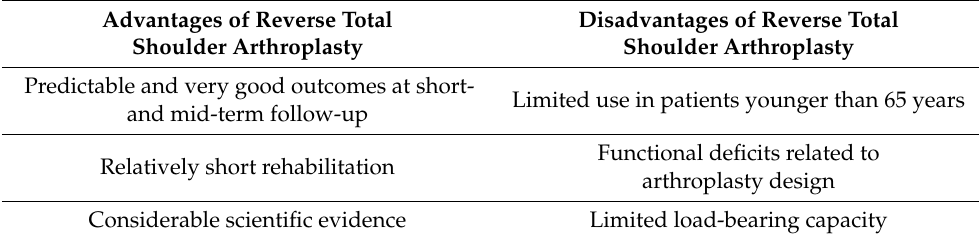
Table 7. Advantages and disadvantages of reverse total shoulder arthroplasty. Advantages of Reverse